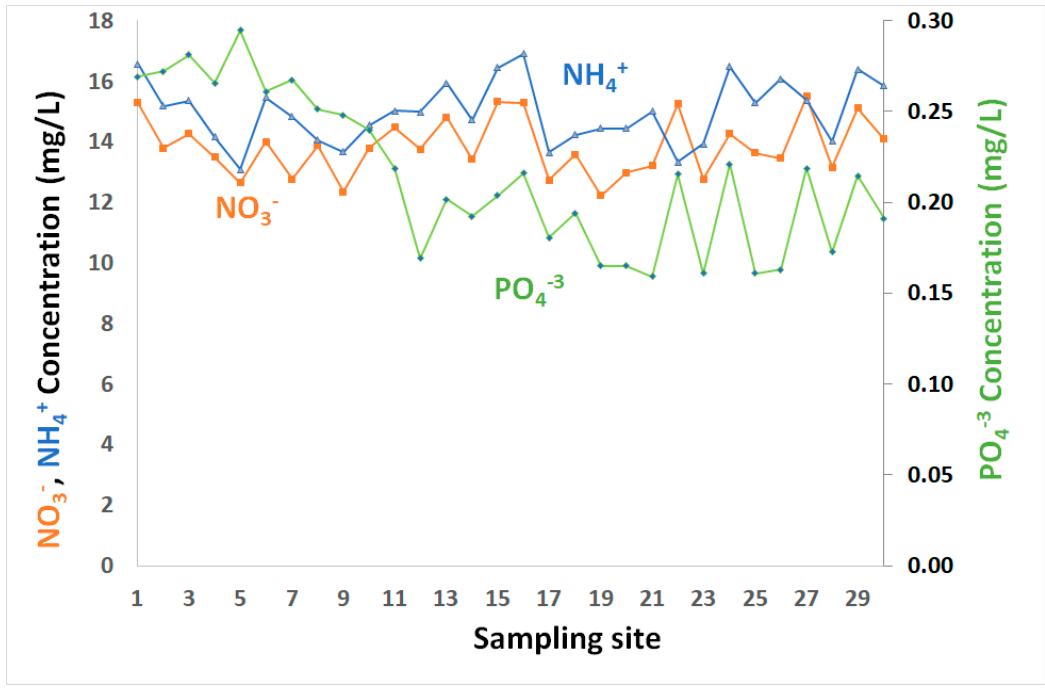
Figure 3. NO 3 − , NH 4+ and PO 4 − 3 in coastal water of the GoA, Jordan.